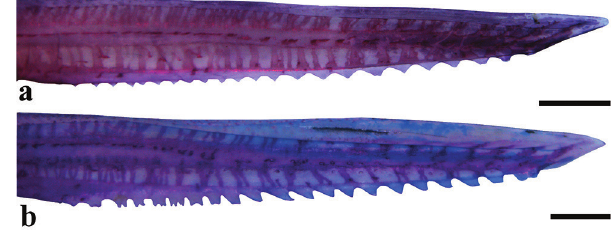
Fig. 4. Pectoral-fin spine of cleared-and-stained specimens of (a) Corydoras paleatus , UFRGS 1722, 37.6 mm SL, and (b) Corydoras froehlichi , MCP 13388, 40.2 mm SL, paratype. Scale bar = 1.0